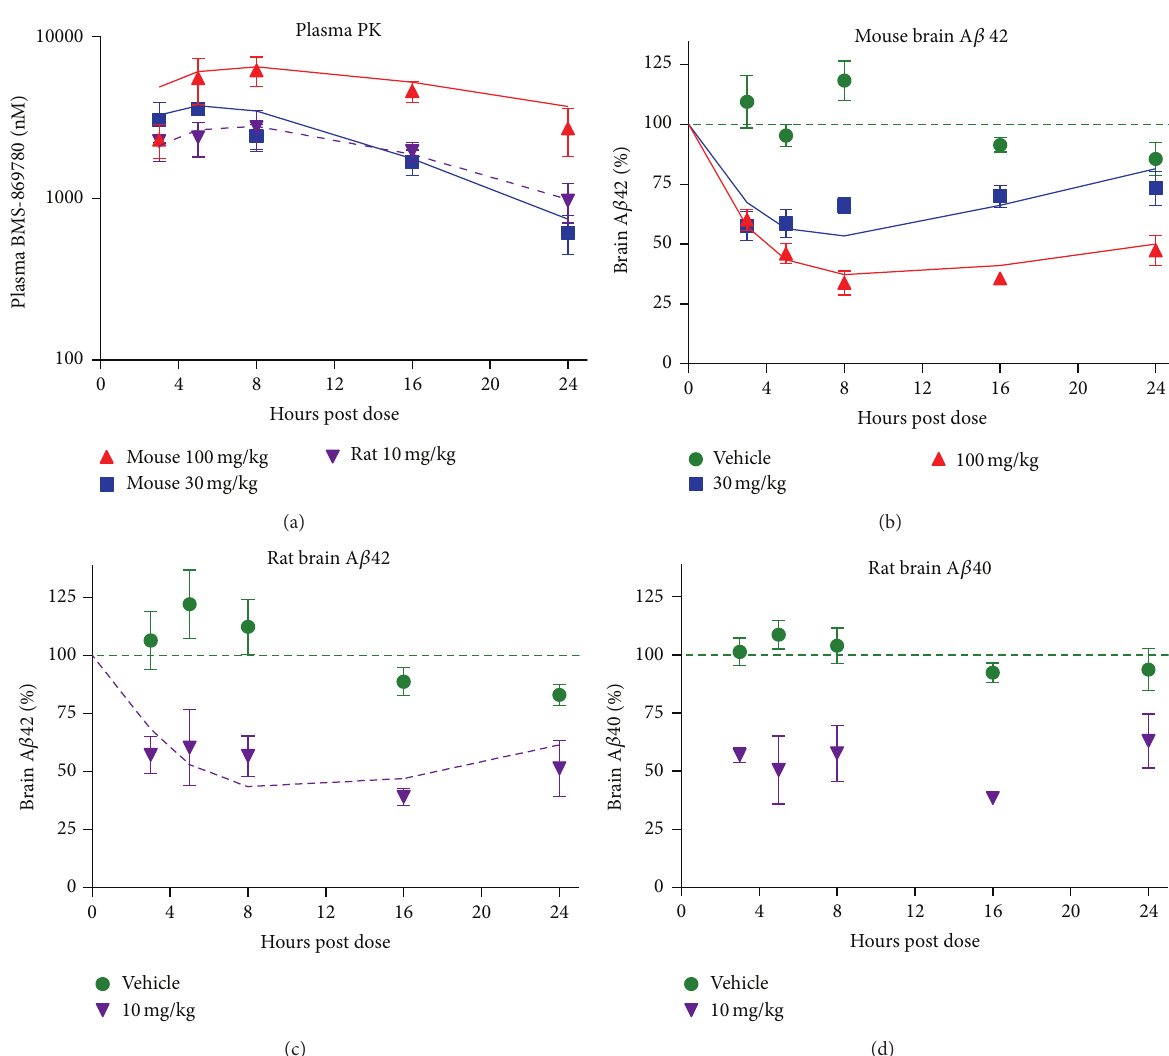
Figure 8: Analysis of the PK/PD relationship for BMS-869780 in rats and mice. Rats were dosed orally with BMS-869780 at 10mg/kg, and triple transgenic mice were orally dosed at 30 mg/kg and 100 mg/kg. Additional groups of rats and mice were dosed with vehicle alone. Brain and plasma were harvested at 3, 5, 8, 16, and 24 hours after dosing for determination of brain A 𝛽 1-42 and plasma BMS-869780 concentration. Group sizes were 5 rats or 4 mice. Whiskers represent standard error. (a) Plasma concentrations of BMS-869780 were determined for the mice dosed at 100 mg/kg ( 󳵳 ) and 30 mg/kg ( ◼ ) and for the rats dosed at 10mg/kg ( 󳶃 ). The data were fit to a one-compartment PK model and the predicted plasma BMS-869780 concentrations are shown for mouse (solid lines) and rat (broken line). (b) Brain A 𝛽 1-42 levels were determined for the mice dosed with BMS-869780 at 100 mg/kg ( 󳵳 ), 30 mg/kg ( ◼ ), or vehicle alone ( e ). The data were fitted using the indirect pharmacodynamic response model and predicted values are shown (solid lines). (c) Brain A 𝛽 1-42 levels were determined for the rats dosed with BMS-869780 at 10mg/kg ( 󳶃 ) or vehicle alone ( e ). The data were fitted using the indirect pharmacodynamic response model and predicted values are shown (dashed line). The values of the PK and PD parameters determined from these experiments are